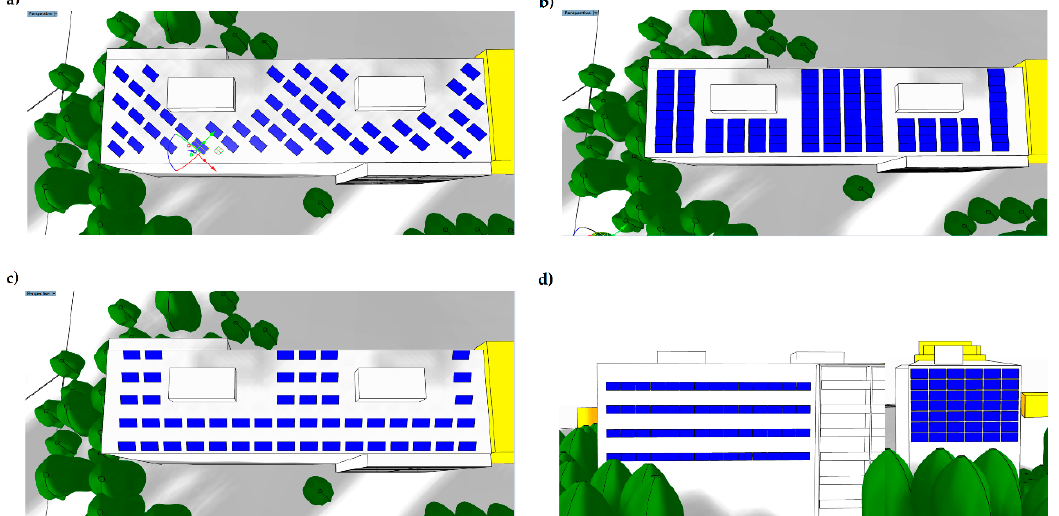
Figure 8. Selected PV configurations for ( a ) maximizing generated electricity per kW p , ( b ) maximizing installed PV capacity according to the available space, ( c ) balanced solution between performance and installed capacity and ( d ) vertical integration based on the solar analysis results.